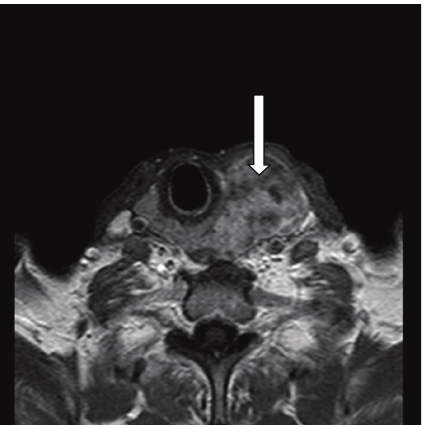
Figure3:Magneticresonanceimagingscanshowingheterogeneous mass in relation to the left thyroid lobe marked with an arrow.